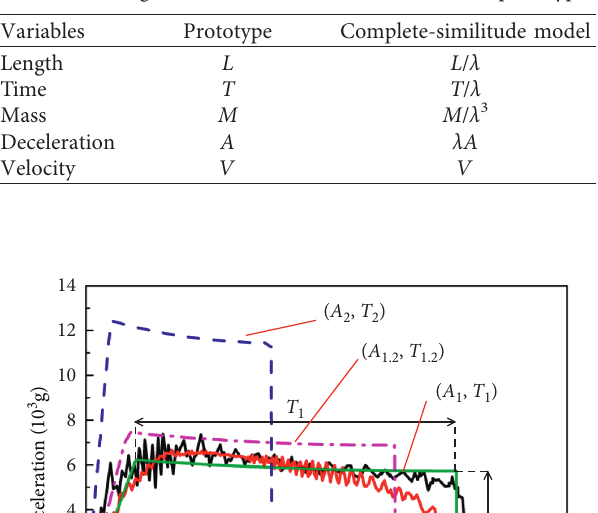
Table 1, the deceleration-time curves of finite element analysis with different scaling factors are shown in Figure 1.